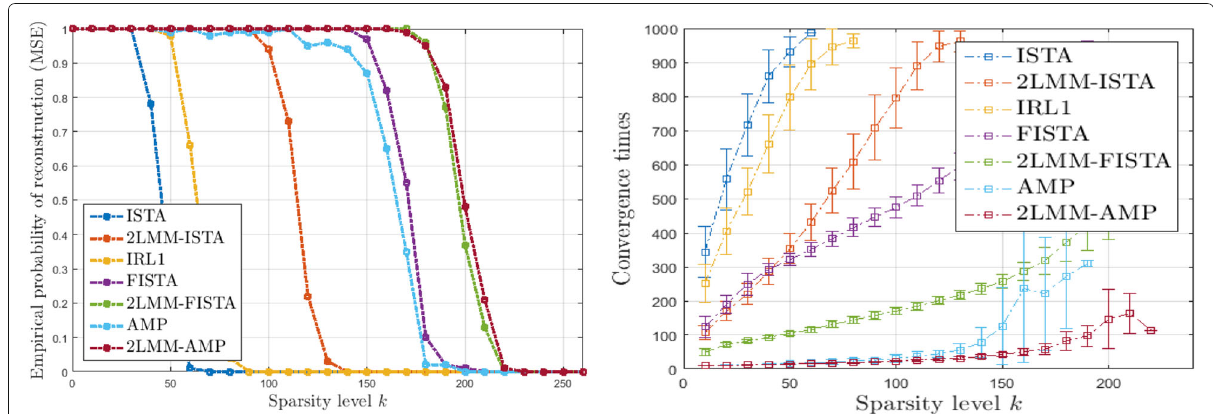
Fig. 8 Analysis of performance for U1 signals: empirical probability of successful recovery as a function of the sparsity value k with n = 512 and m = 350 for sparse Bernoulli-Uniform signals (U1) with zero mean and variance 1 / m . Then, the reconstruc- tion is performed using measurements y = Ax (cid:3) . The first-order methods are compared with their versions aug- mented by 2-LMM-tuning: the parameters have been ini- tialized as follows: λ = 10 − 3 , τ = 0.1, α ( 0 ) = 1, π ( 0 ) = 1 ,